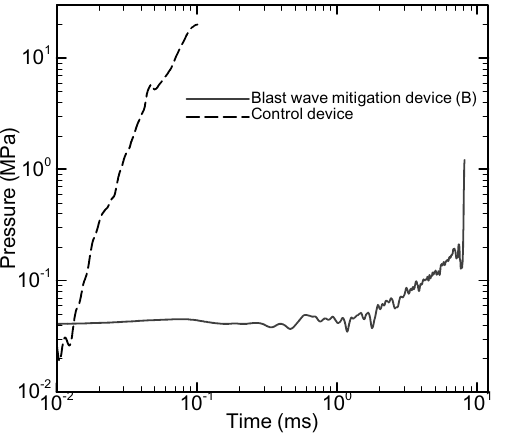
Fig. 13. Pressure obtained from the Hopkinson bar test on the base of the blast wave mitigation device (B) and of the corresponding control device. pressure inside the blast wave mitigation device increases at a faster rate. At about 6.8 ms, the piston comes to a complete stop. The pressure on the base of the blast wave mitigation device reaches its maximum value of